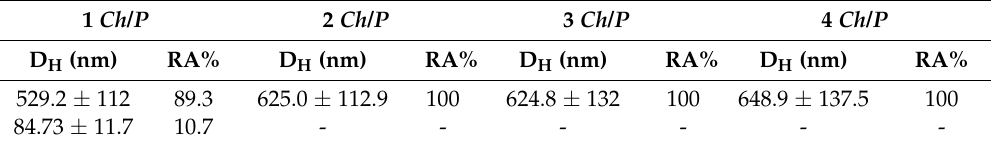
Table 3. Values of the hydrodynamic diameter (D H ) and the relative amount (RA (%)) as obtained by DLS for chitosans/Phospholipids ( Ch / P ).